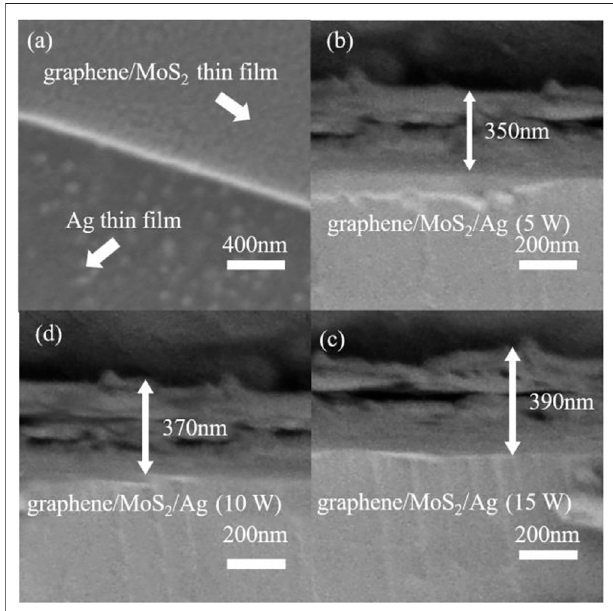
FIGURE4|(A) ThemorphologyoftheBthin fi lmandthethicknessofthe B 1 (B) , B 2 (C) , and B 3 (D) thin fi lms.